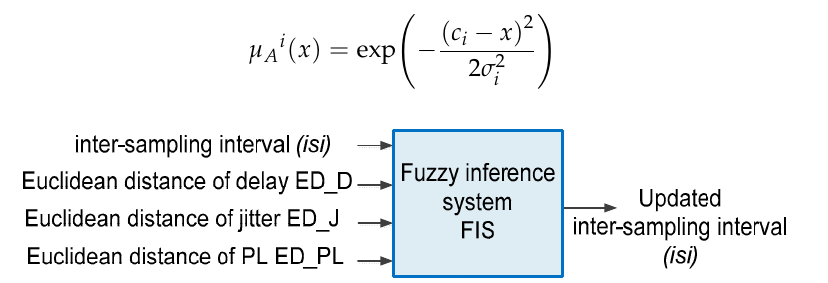
Figure 6. Fuzzy system to update isi duration.